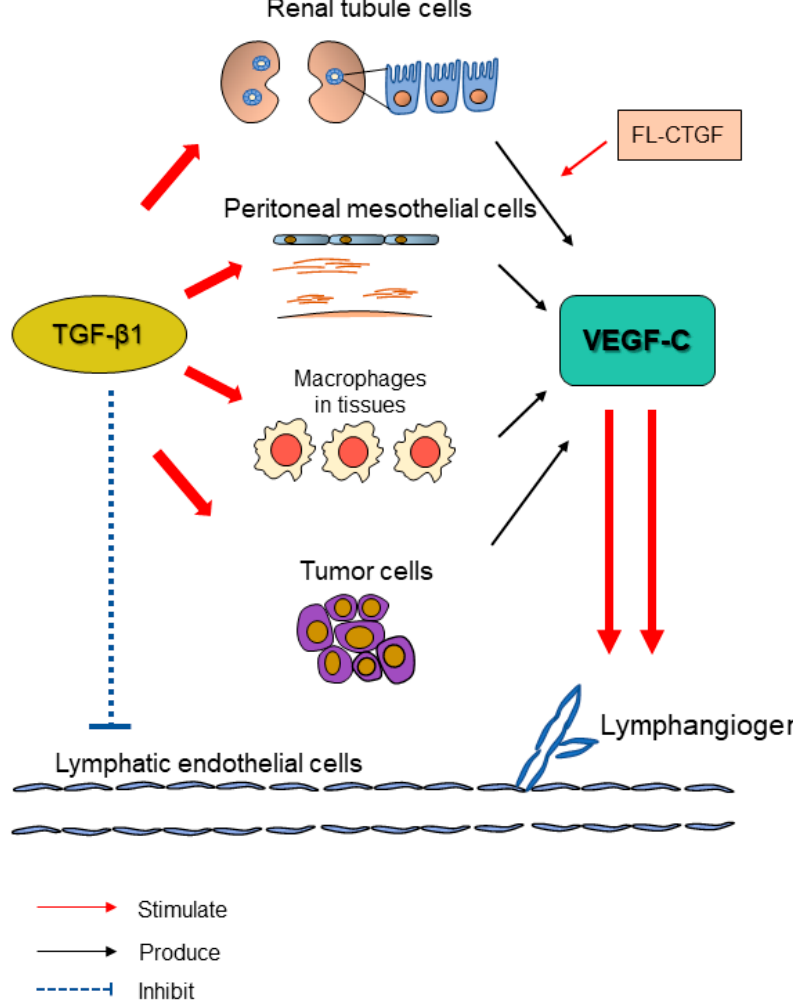
Figure 1. Transforming growth factor- β (TGF- β ) promotes tissue lymphangiogenesis via upregulating vascular endothelial growth factor (VEGF)-C in various fibrotic pathologies (kidney fibrosis, peritoneal fibrosis, tissue inflammation, and tumor microenvironment). Lymphangiogenesis